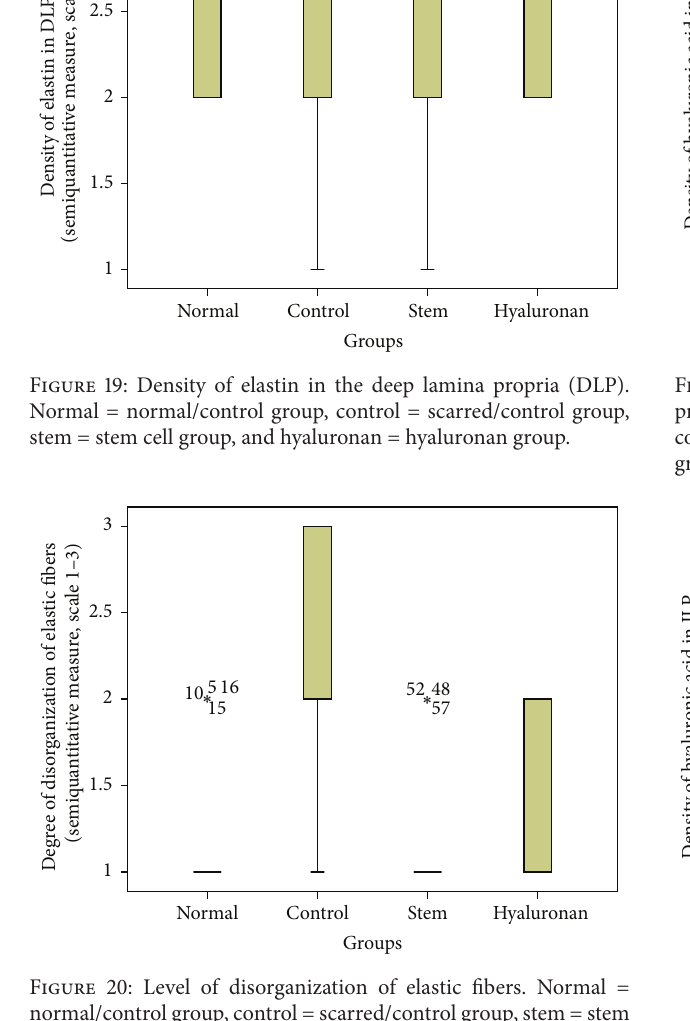
Figure 22: Density of hyaluronic acid in the intermediate lamina propria (ILP). Normal = normal/control group, control = scarred/ control group, stem = stem cell group, and hyaluronan = hyaluronan